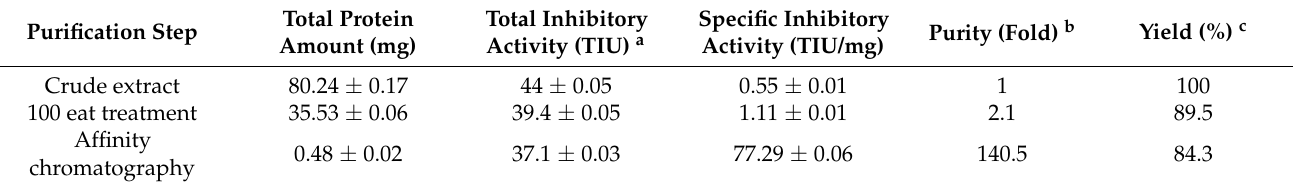
Table 1. Trypsin inhibitory activity.